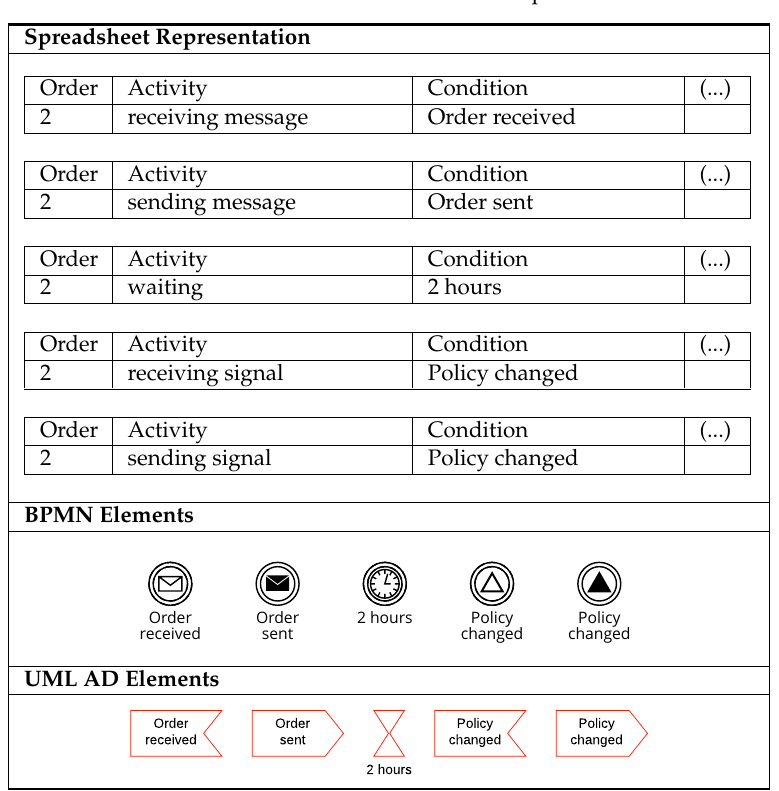
Table 6. Intermediate event examples.